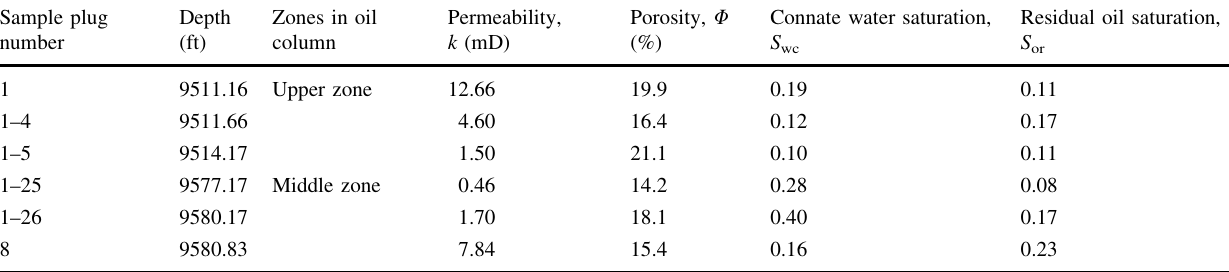
Table 1 Plug core samples properties Sample plug